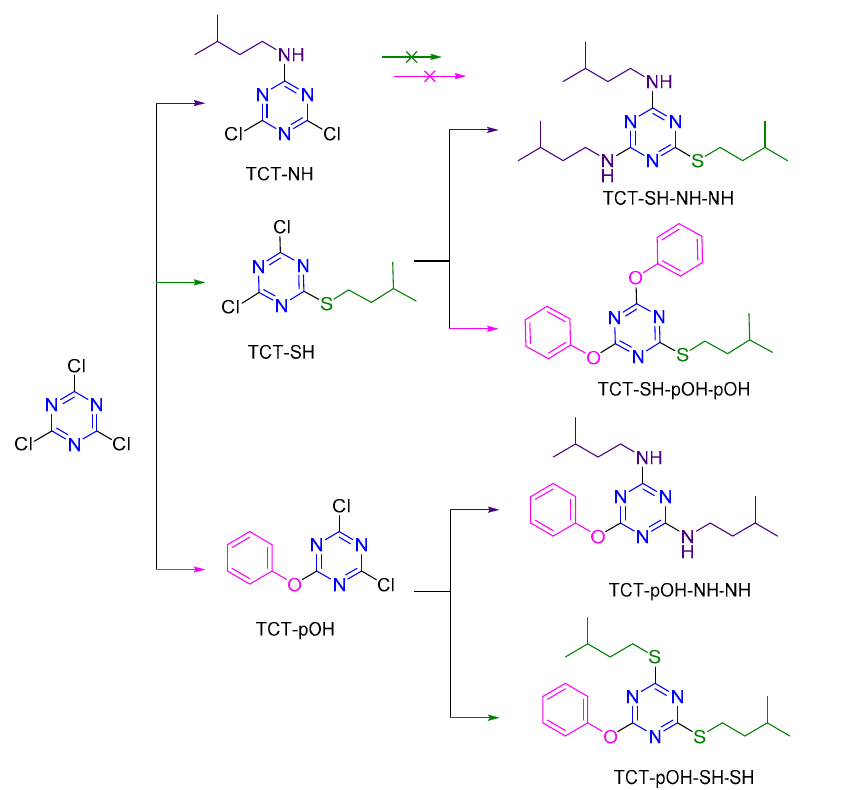
Figure 8. Competitive reaction of TCT with all nucleophiles in one